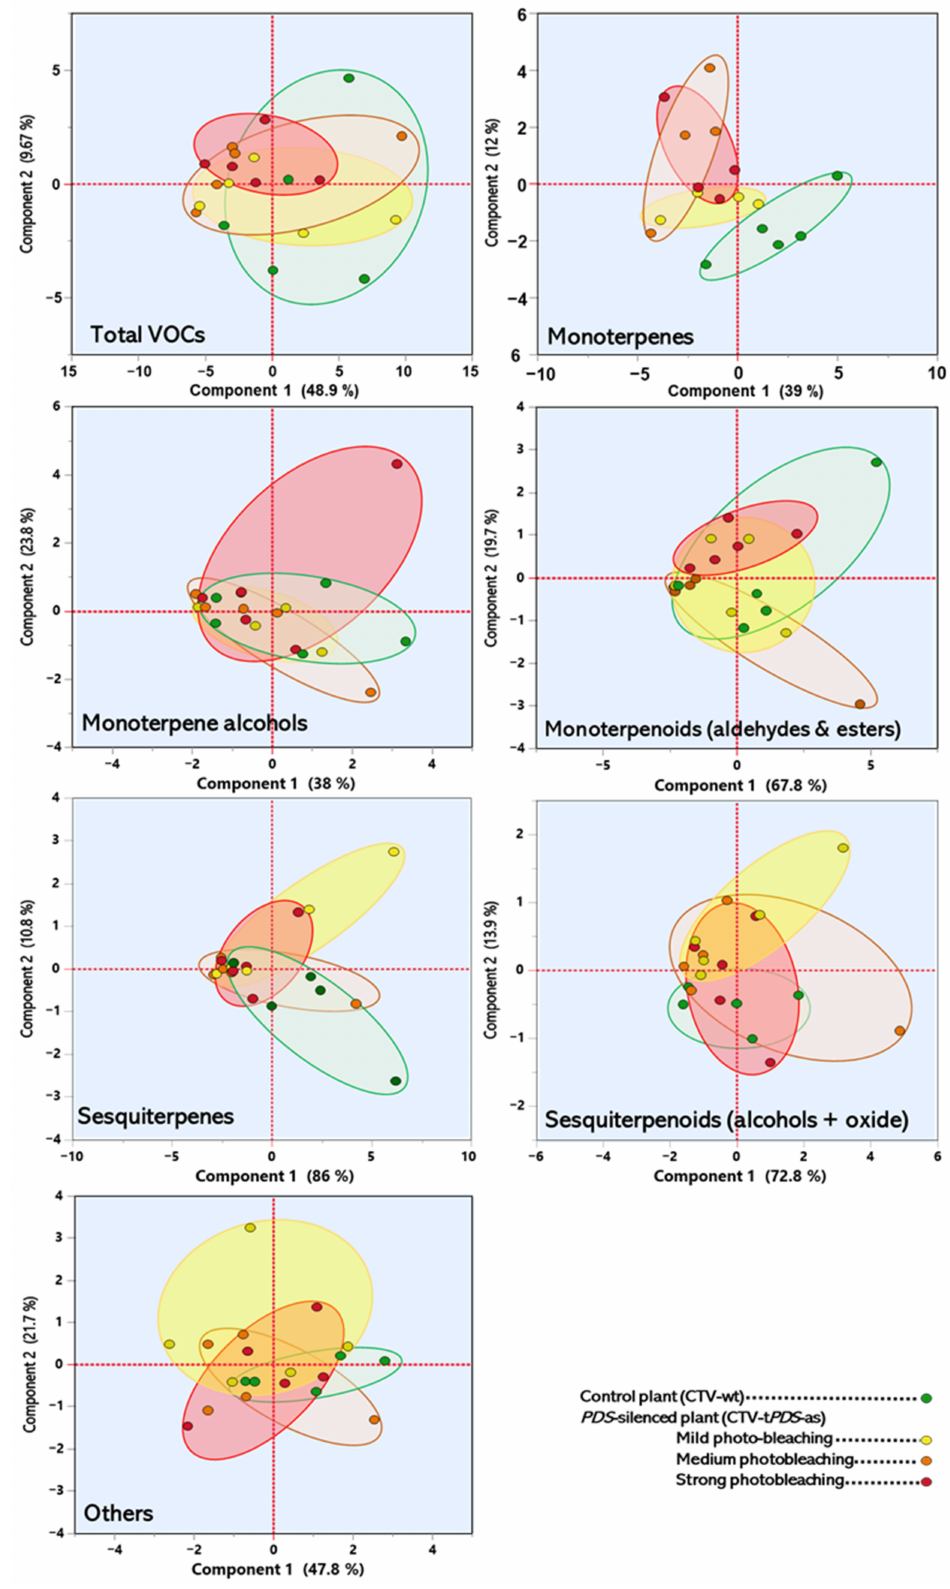
Figure 3. Principal component analysis of the VOCs released from the leaves of C. macrophylla with different degrees of photobleaching using total VOC and individual classes. For the members of each class, see Table